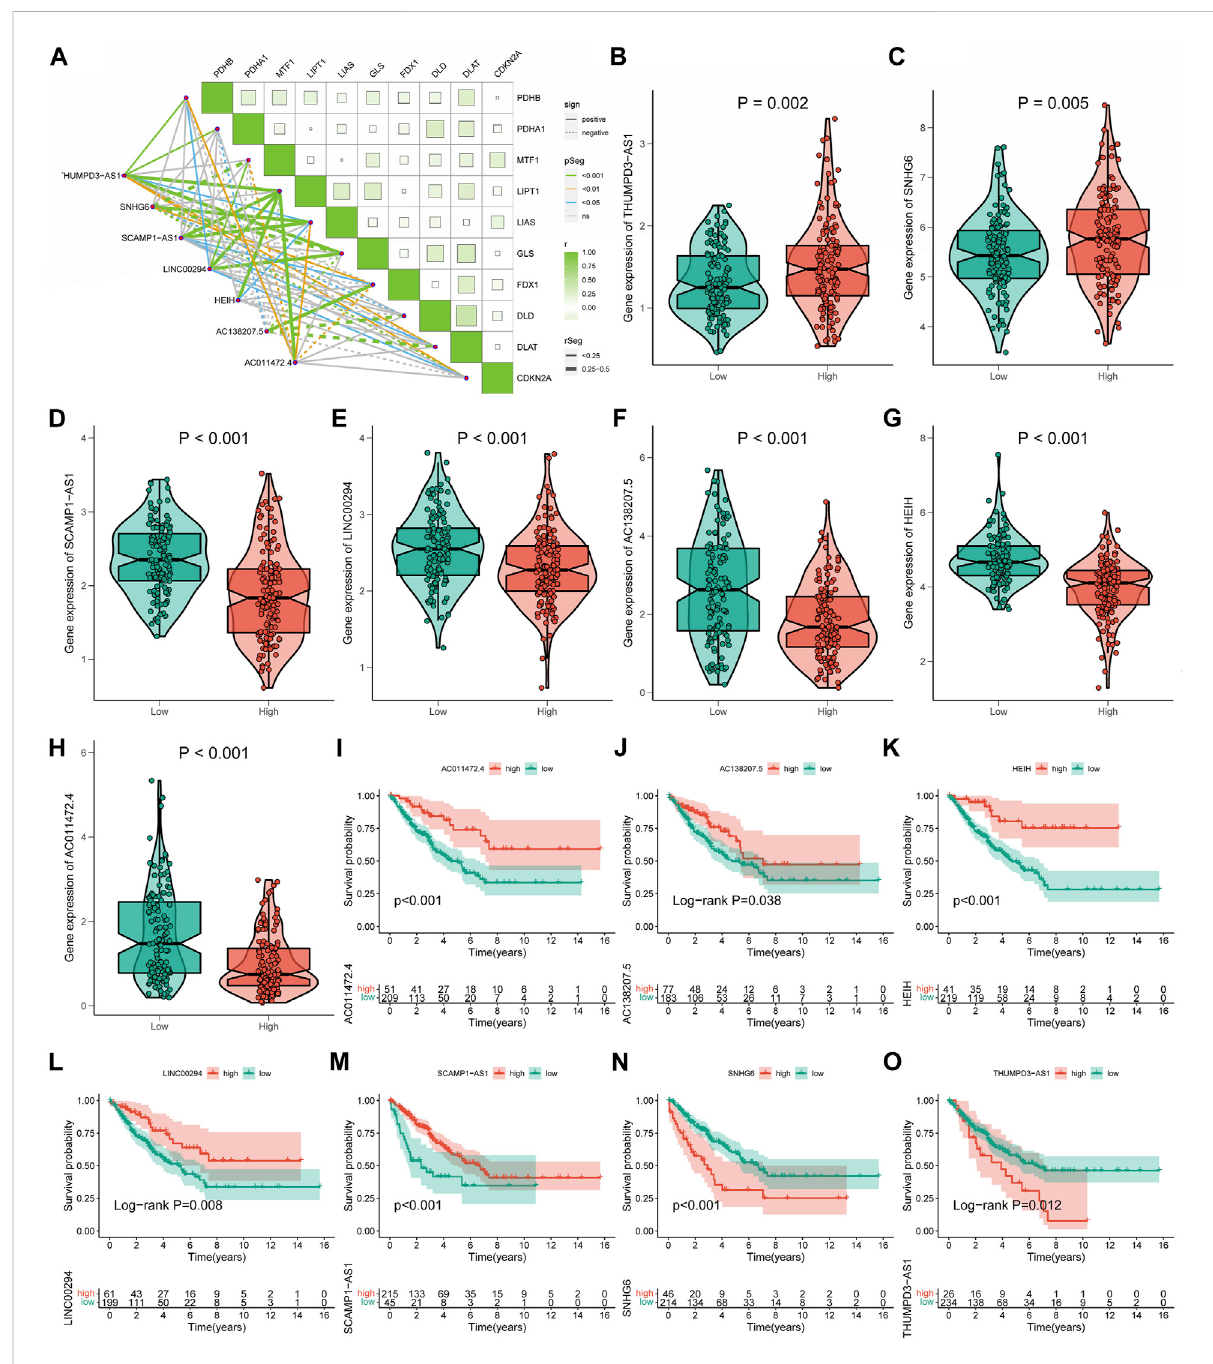
FIGURE 5 The relationships of seven signature CRLs with STS and cuproptosis. (A) Co-expression analysis of the seven signature CRLs with CRGs. (B – H) The expression level of seven signature CRLs in low-CRLncSig and high-CRLncSig groups. (I – O) The K-M survival curves for seven signature CRLs.